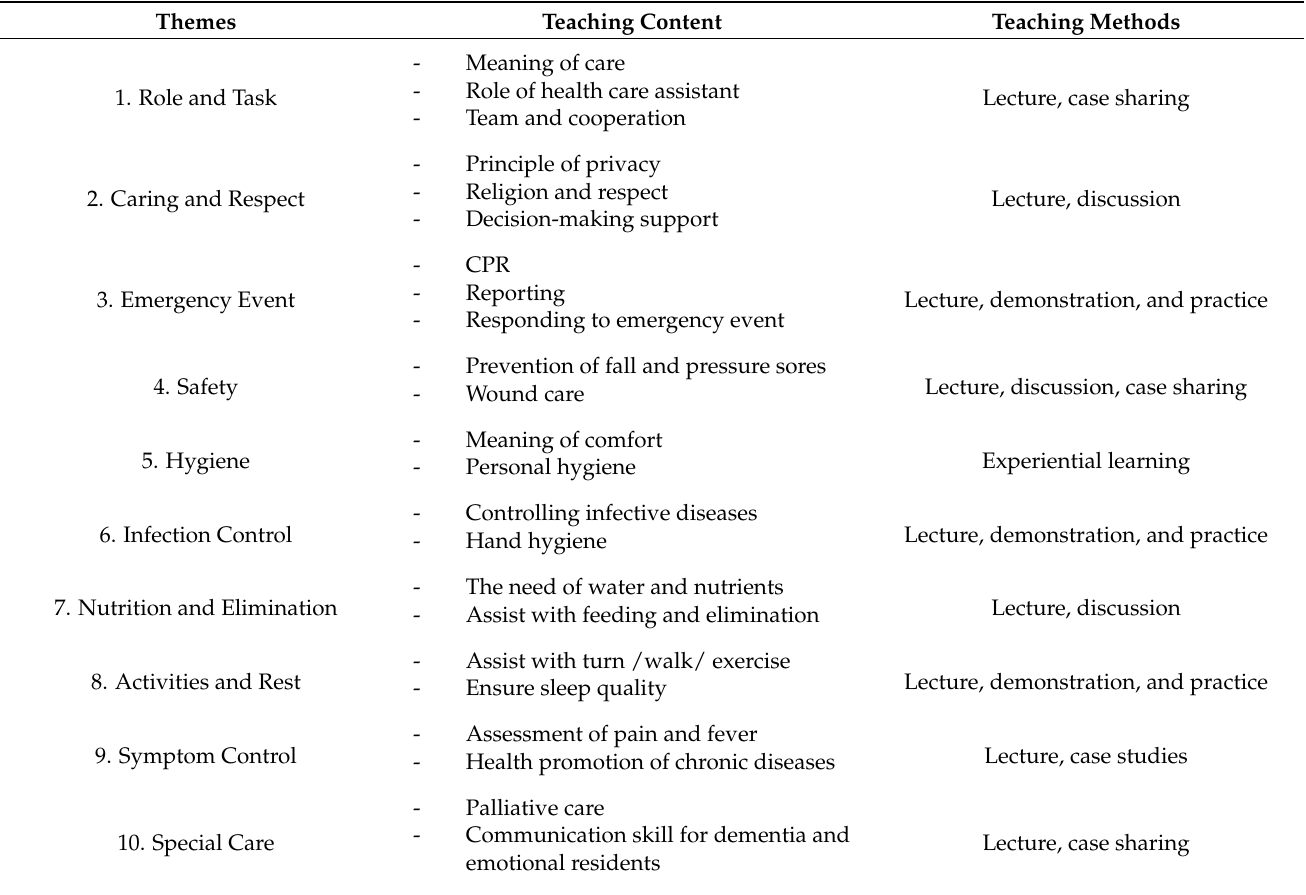
Table 1. The teaching plan of the continuous education